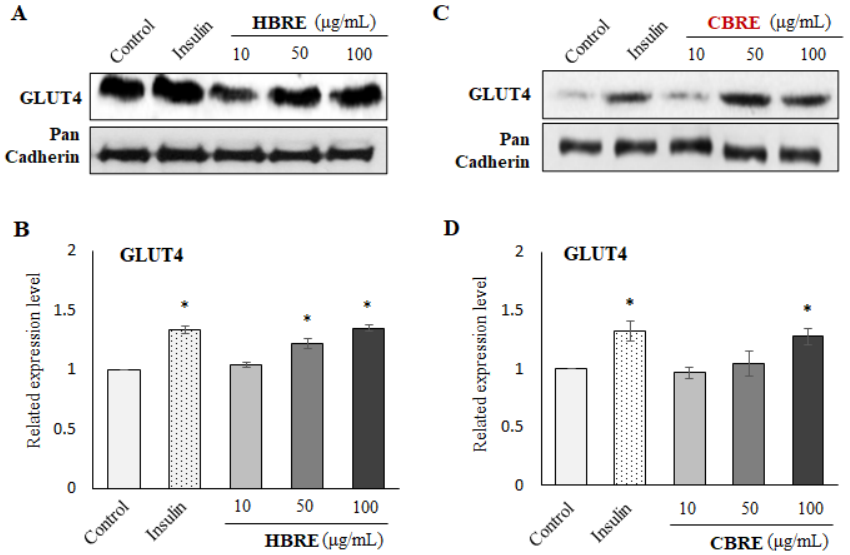
Figure 2. Effect of black rice extracts on glucose uptake by C2C12 myotubes. The 2-NBDG glucose uptake analysis was measured after a 24-h treatment with the indicated concentrations of ( A ) HBRE and ( B ) CBRE. Data are presented means ± SD, * p < 0.05 vs. control group.